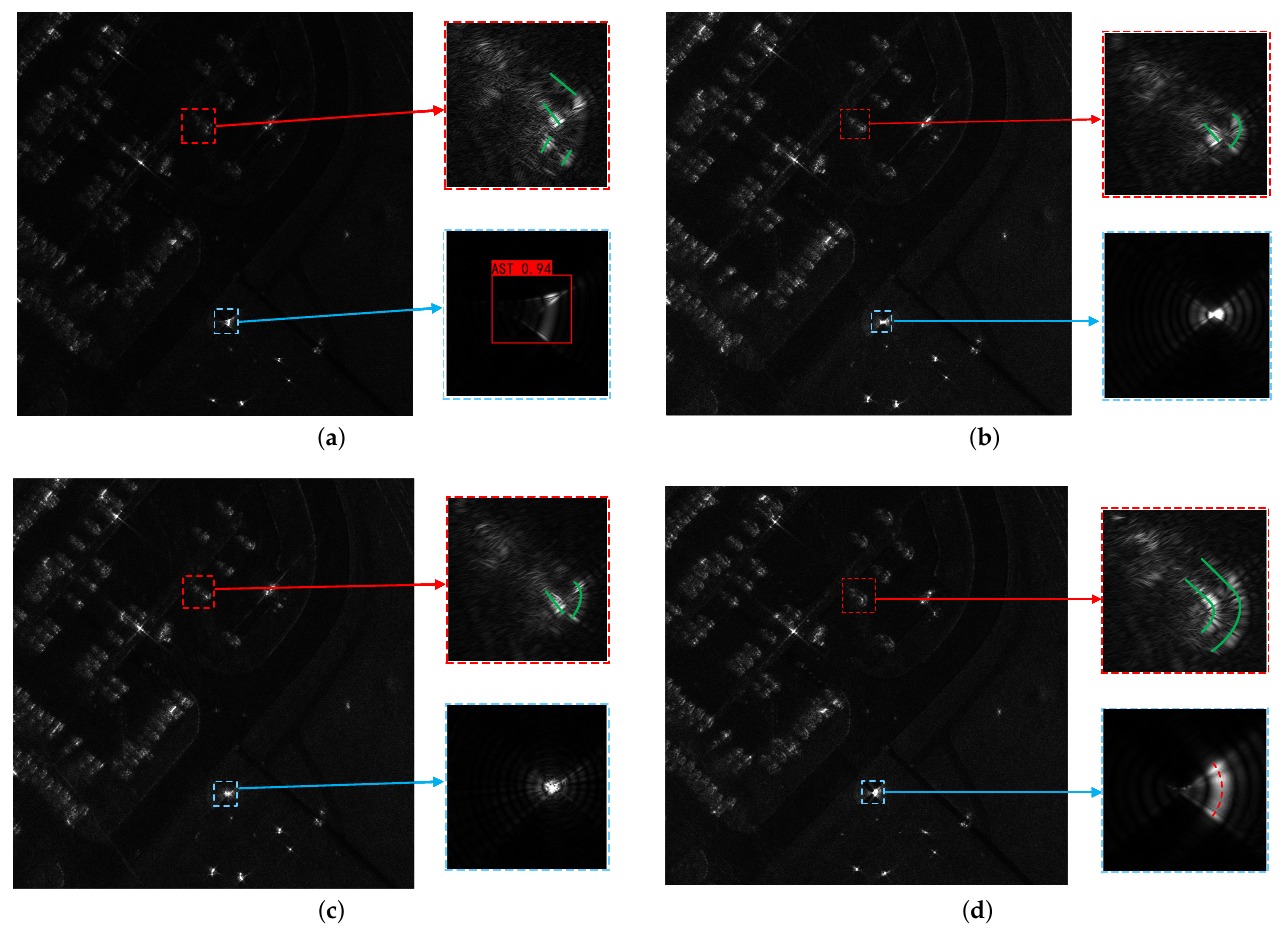
Figure 18. Experimental results of publicly released data: ( a ) the BP result of real trajectory; ( b ) the PGA result; ( c ) the MSE result; ( d ) the proposed SPA-GAN result.